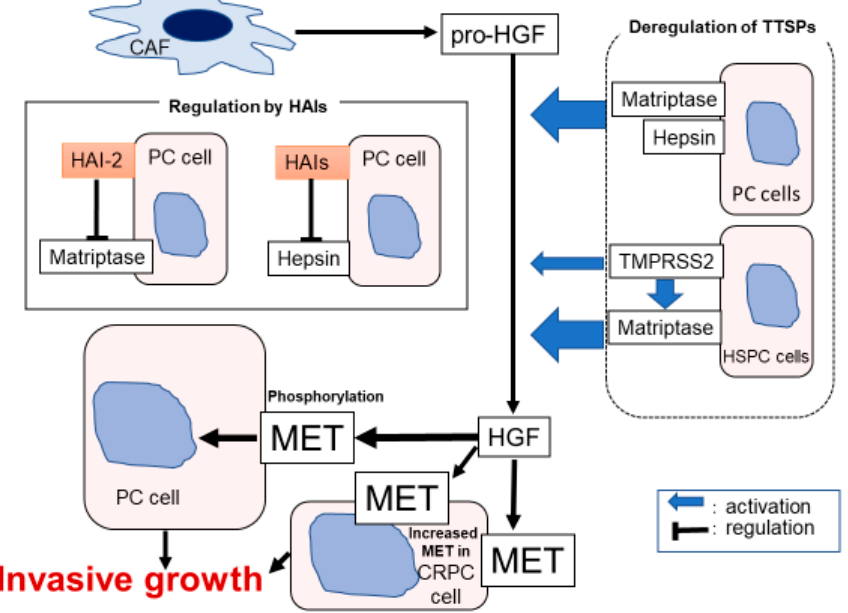
Figure 4. Hypothetical model of pericellular activation of hepatocyte growth factor zymogen (pro-HGF) in prostate cancer (PC) is shown. Downregulation of HAIs induced dysregulated overactivation of matriptase, hepsin, and TMPRSS2, leading to HGF-dependent phosphorylation of MET.